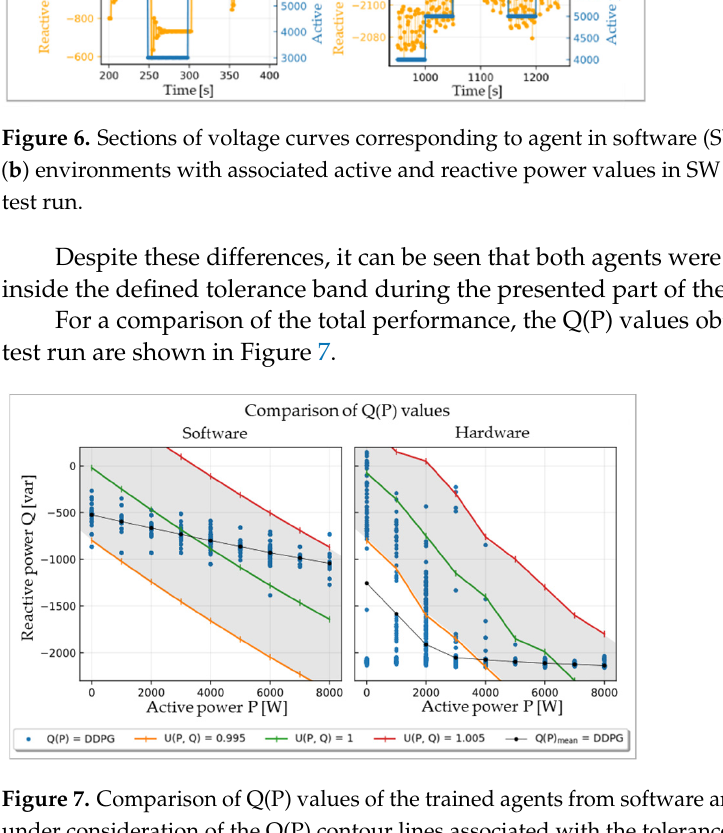
Figure 7. Comparison of Q(P) values of the trained agents from software and hardware in the test run under consideration of the Q(P) contour lines associated with the tolerance band limits of ±0.005